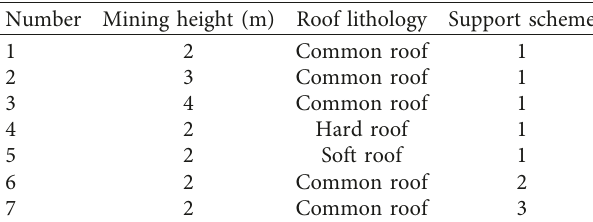
Table 6: Simulation